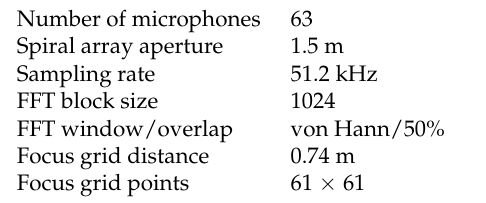
Table 4. Experimental data acquisition and processing parameters.